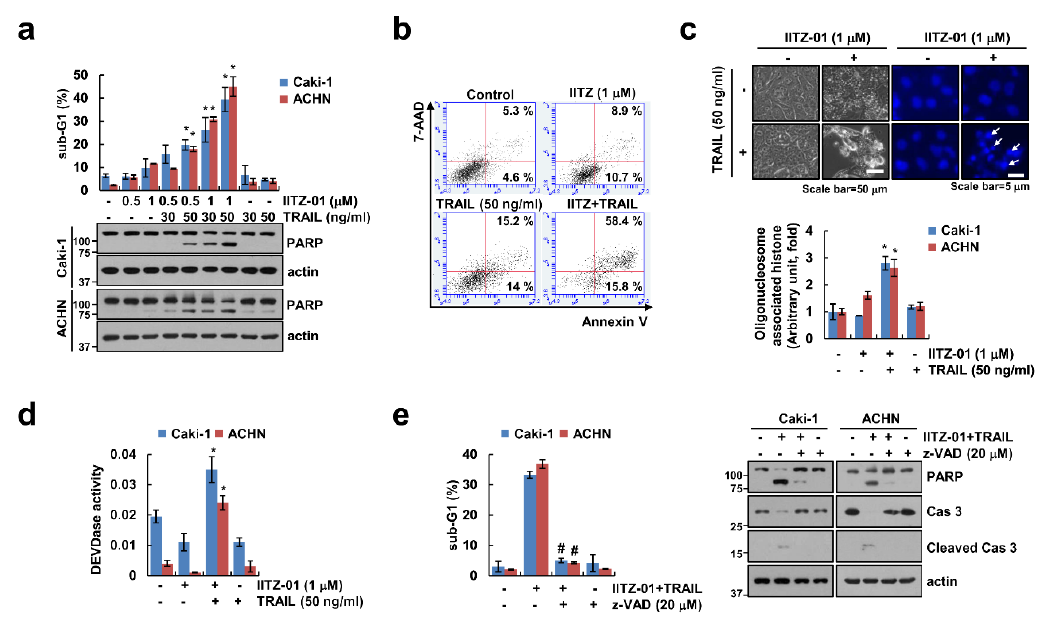
Figure 1. IITZ-01 sensitizes renal carcinoma cells to TNF-related apoptosis-inducing ligand (TRAIL-induced apoptosis. ( a ) Caki-1 and ACHN cells were incubated with indicated concentrations with IITZ-01 and/or TRAIL for 18 h. The apoptotic population (sub-G1) and protein levels were analyzed by flow cytometry and Western blotting, respectively; ( b , c ) Caki-1 cells were incubated with 1 μM IITZ-01 and/or 50 ng/mL TRAIL for 18 h. Cell death was detected using Annexin V/7-AAD staining ( b ). The cell morphology was examined using interference light microscopy. Nuclei condensation and DNA fragmentation were detected using 4′,6′-diamidino-2-phenylindole (DAPI) staining and DNA fragmentation detection kit, respectively ( c ); ( d ) Caki-1 and ACHN cells were incubated with 1 μM IITZ-01 and/or 50 ng/mL TRAIL for 18 h. DEVDase (caspase-3) activity was examined using kit as a described in a Material and Methods; ( e ) Caki-1 and ACHN cells were incubated with 1 μM IITZ-01 plus 50 ng/mL TRAIL in the presence or absence of 20 μM z-VAD-fmk (z-VAD). The values in graph ( a,c – e ) represent the mean ± SD of three independent experiments. * p < 0.05 compared to the control. # p < 0.05 compared to IITZ-01 plus TRAIL.